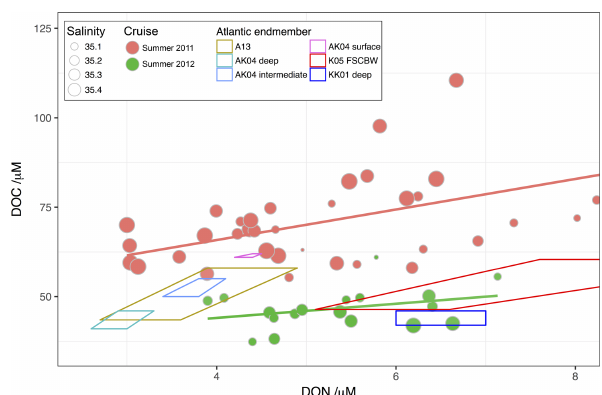
Figure 12. DOM stoichiometry from northern stratified bottom wa- ter samples in summer 2011 (red) and 2012 (green), compared with open North Atlantic concentrations as follows. A13: Álvarez- Salgado et al. (2013); AK04: Aminot and Kérouel (2004); K05: Kramer et al. (2005); KK01: Kähler and Koeve (2001). These “end- member ranges” were constructed in DOC–DON space based on the ranges of concentrations of DOC and DON quoted in the relevant papers, constrained by limiting possible combinations of DOC and DON that were consistent with the quoted range of observed C : N ratios (in the absence of the full dataset). The full range of DOC concentrations observed in the studies is covered by these derived endmembers, and the large majority of the DON